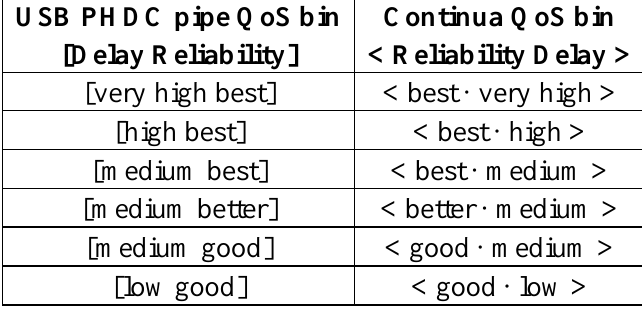
Table 3. USB PHDC pipe QoS bin versus Continua QoS